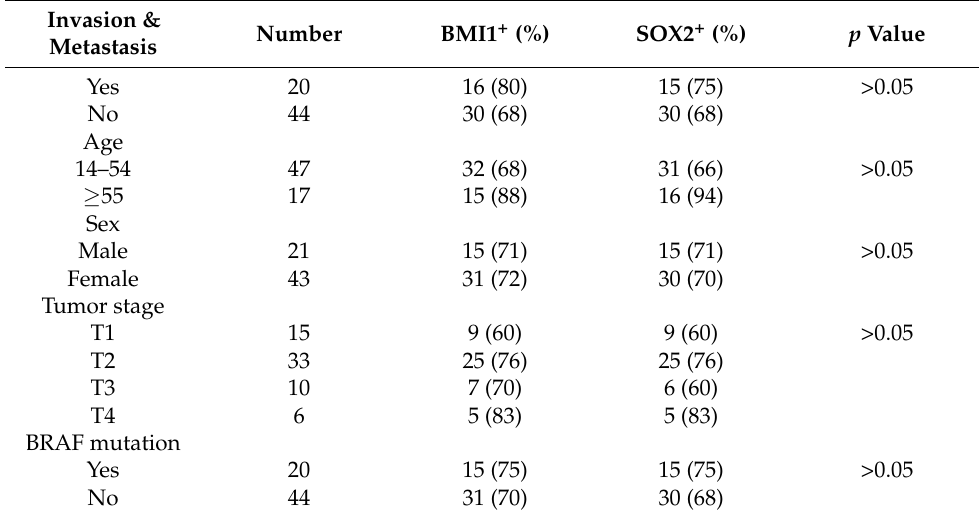
Table 3. Concomitant expression between Gli1 and BMI1 or SOX2.